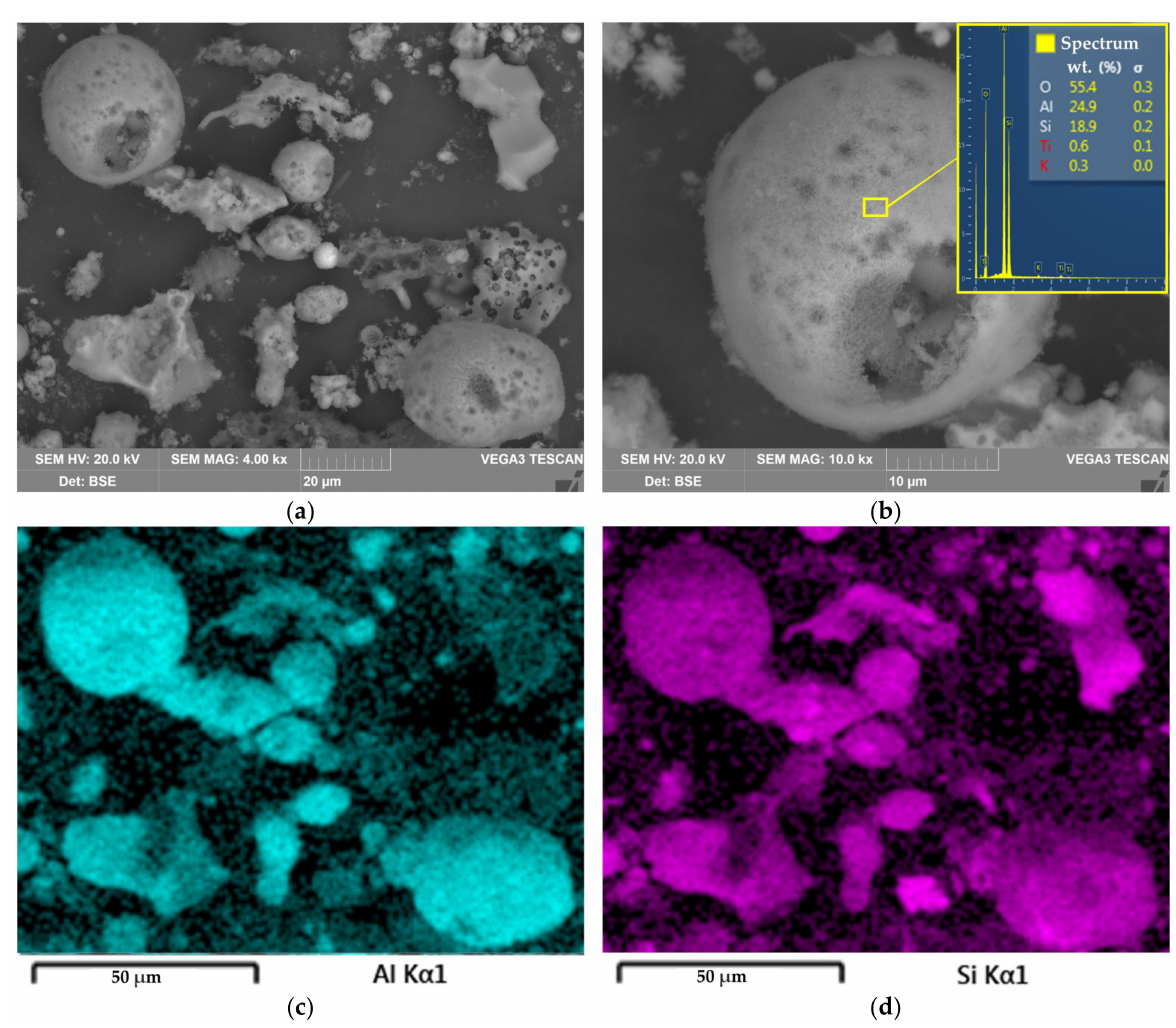
Figure 10. The SEM image of the solid residue particles surface at 4000 magnitude ( a ); the SEM image with EDX spectra of the mullite agglomerate at 10,000 magnitude ( b ); elemental distribution of Al on the surface of particles on Figure 10a ( c ); elemental distribution of Si on the surface of particles on Figure 10a ( d